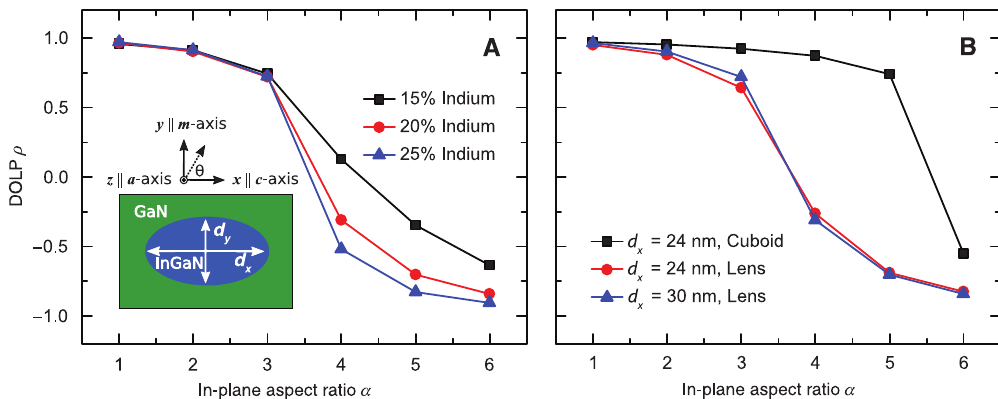
Figure 2: (A) DOLP ρ as a function of the in-plane aspect ratio α and indium content of a lens-shaped a -plane InGaN/GaN QD. The inset shows the coordinate system, the definition of θ as the in-plane angle away from the crystal c -axis (same as that defined in the experimental setup), and the definitions of d and d as the in-plane dimensions of a QD used in the theoretical investigation. α is defined as α = d y x ρ as a function of α , size, and geometry of a